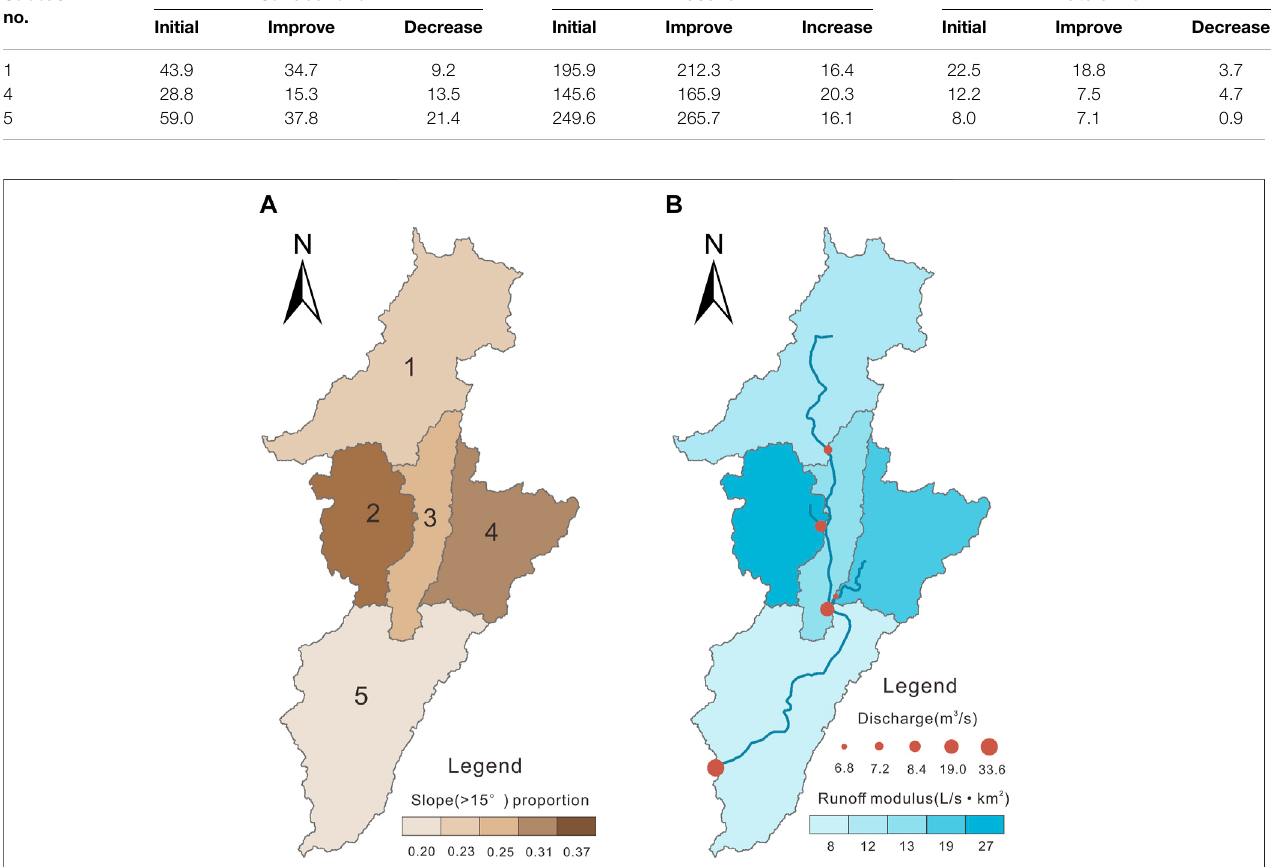
TABLE 3 | Changes in surface runoff depth, base fl ow depth, and lateral fl ow depth in the subbasins No. 1, No. 4, and No. 5 (unit: mm). Subbasin no.